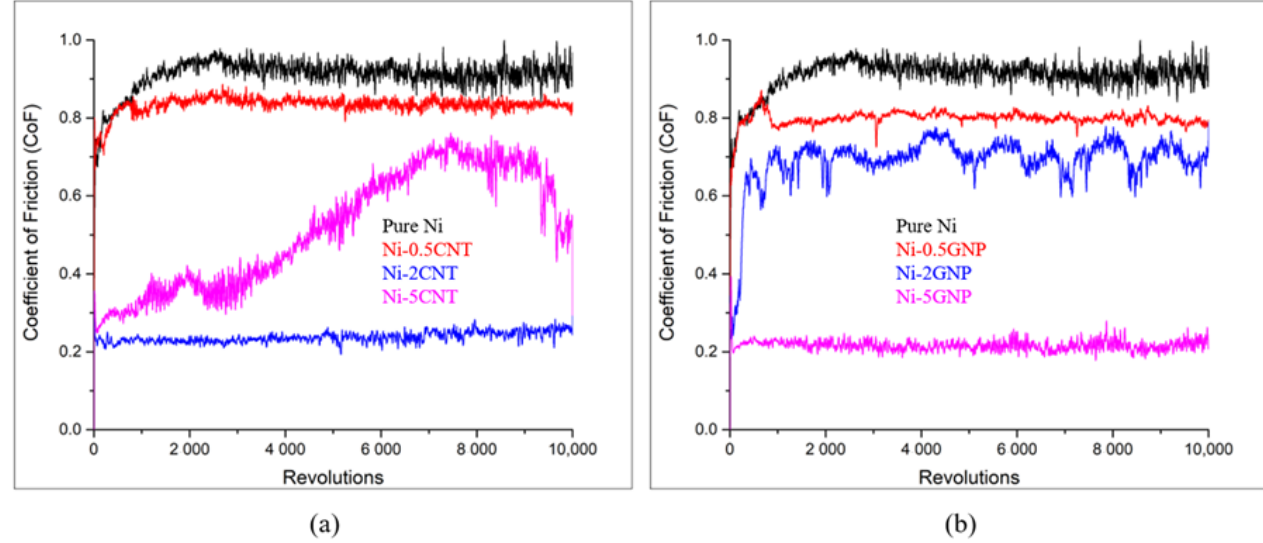
Figure 6. Coefficient of friction plots for ( a ) pure Ni and Ni-CNT composites; ( b ) pure Ni and Ni-GNP composites.